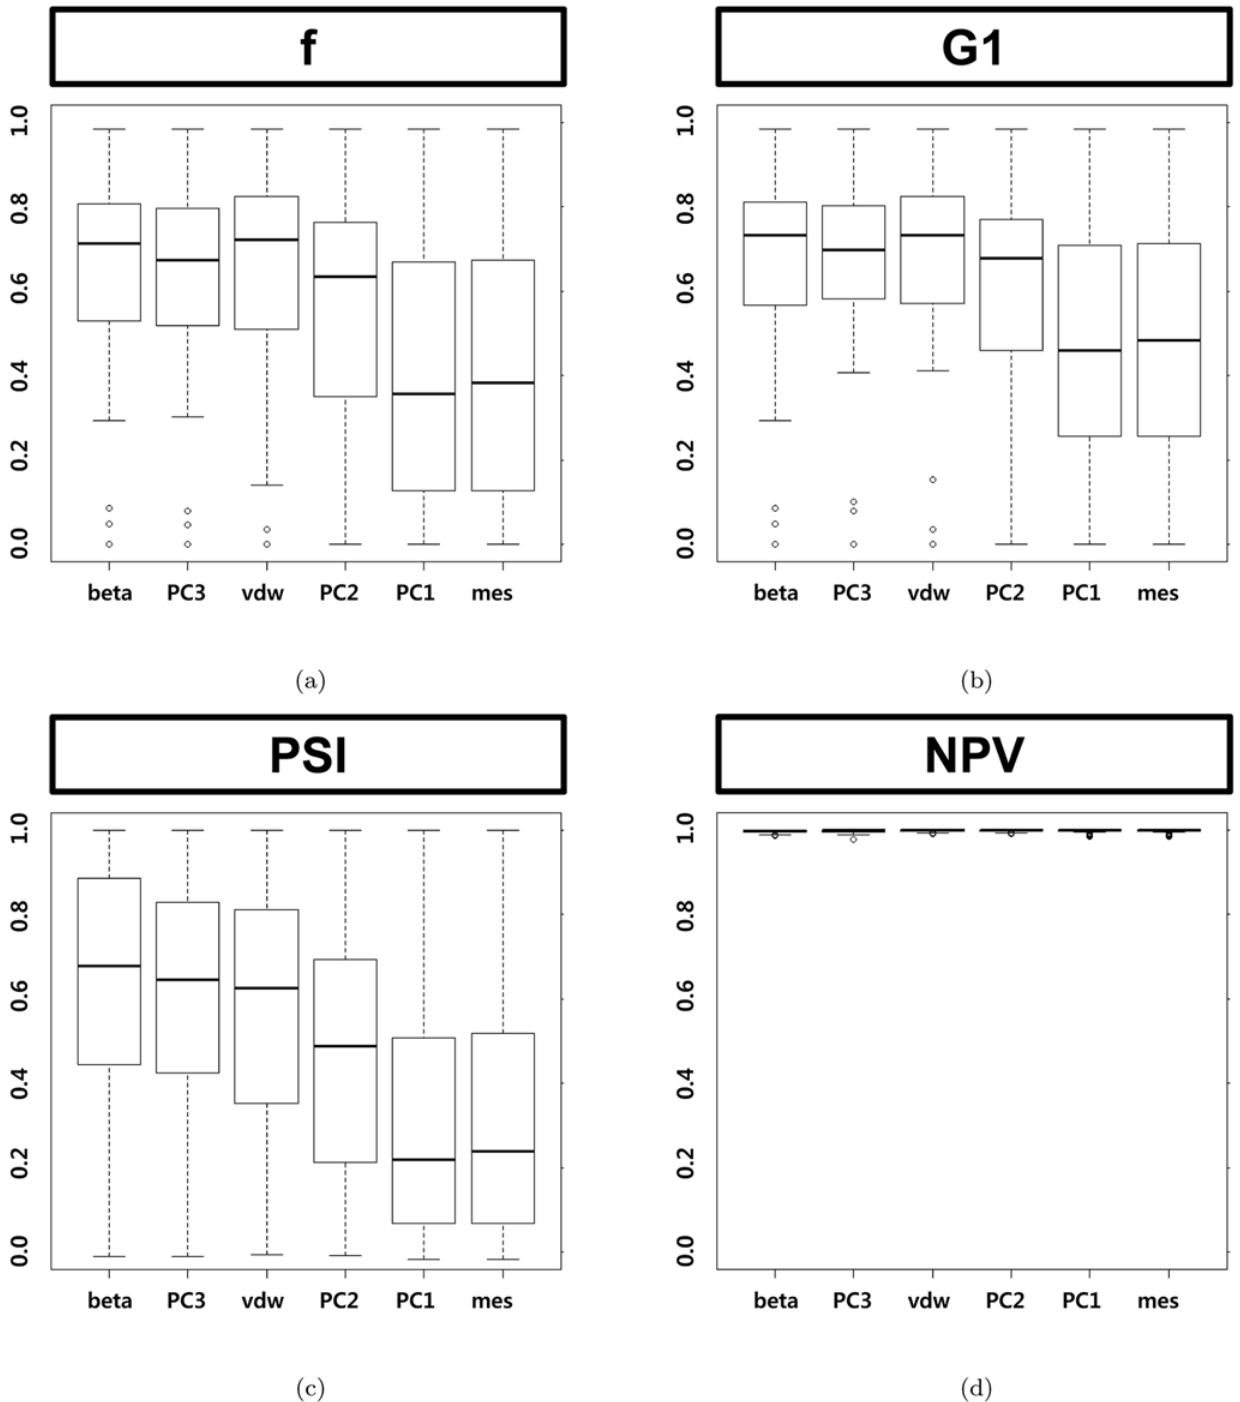
Fig 7. Box plots by Precision-based metrics of the six shape descriptors. (a) F-measure, (b) geometric mean 1 and (c) predictive summary index (d) negative predictive value.